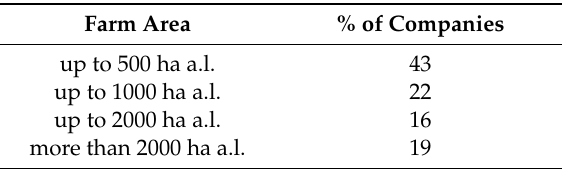
Table 3. Companies according to the farm area.